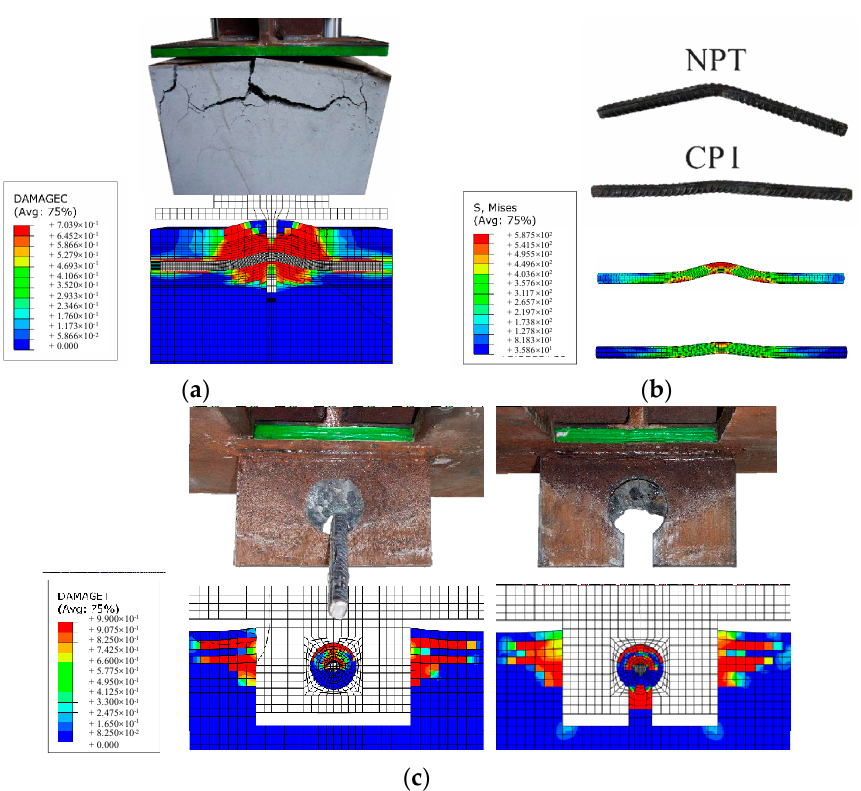
Figure 12. Tested and analyzed failure modes. ( a ) Crack in concrete slab; ( b ) deformation of perforating rebar; ( c ) shear of concrete dowel.